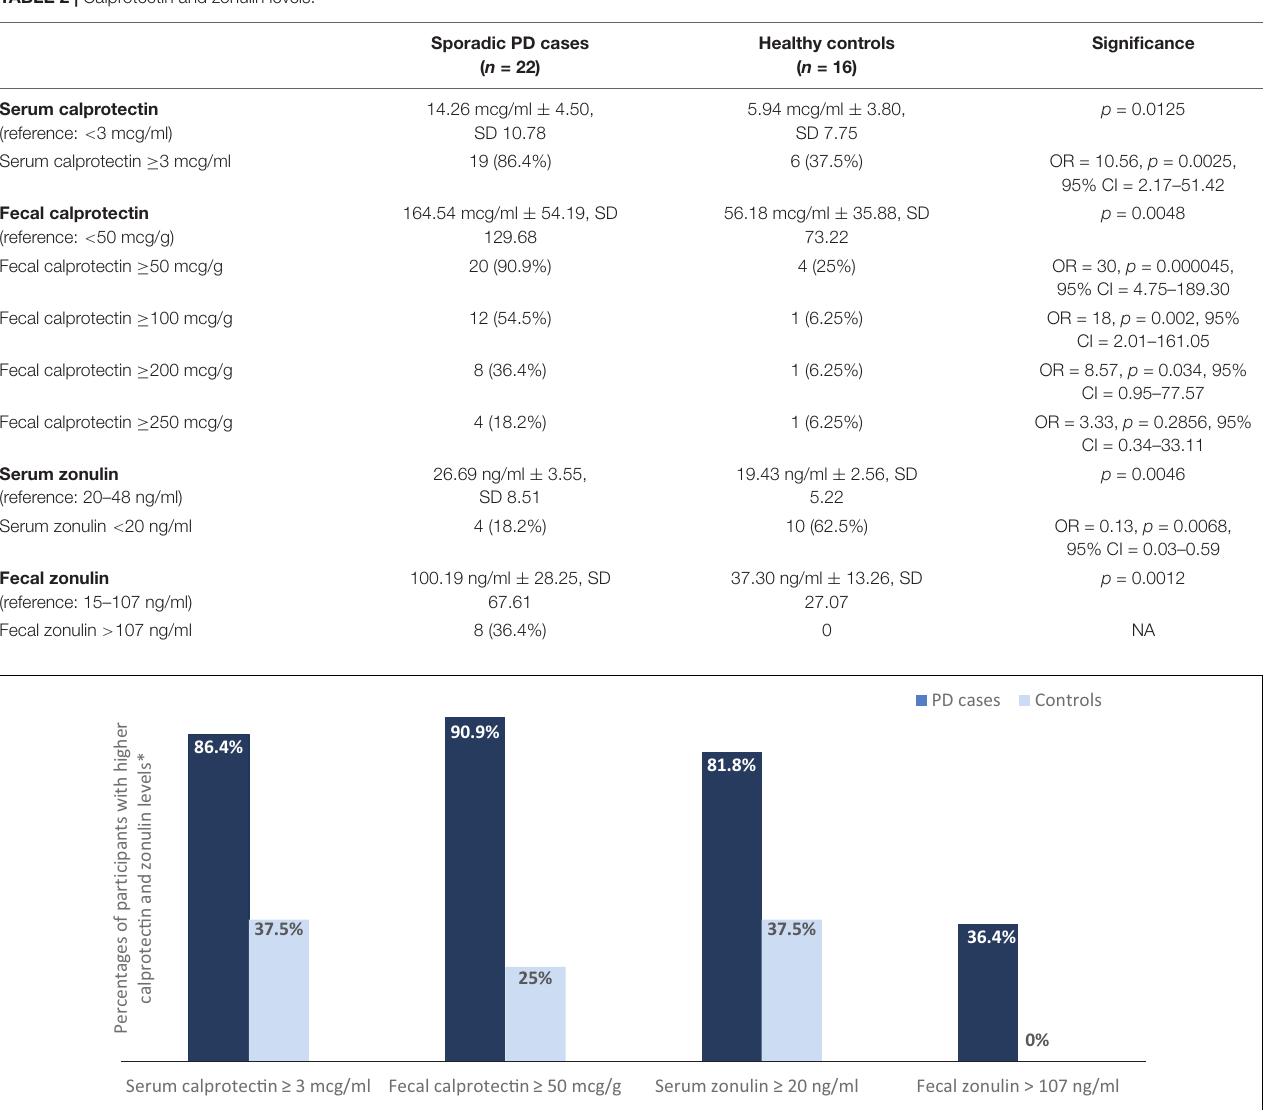
FIGURE 1 | Serum and fecal calprotectin and zonulin levels in the PD group vs. controls. *For serum and fecal calprotectin and fecal zonulin the upper reference limit is used as cut off. Since no study participants had serum zonulin levels above the upper reference limit, but a total of 14 had levels below the lower reference limit (see Table 2 ), for the purpose of this graph the lower reference limit is used as cut